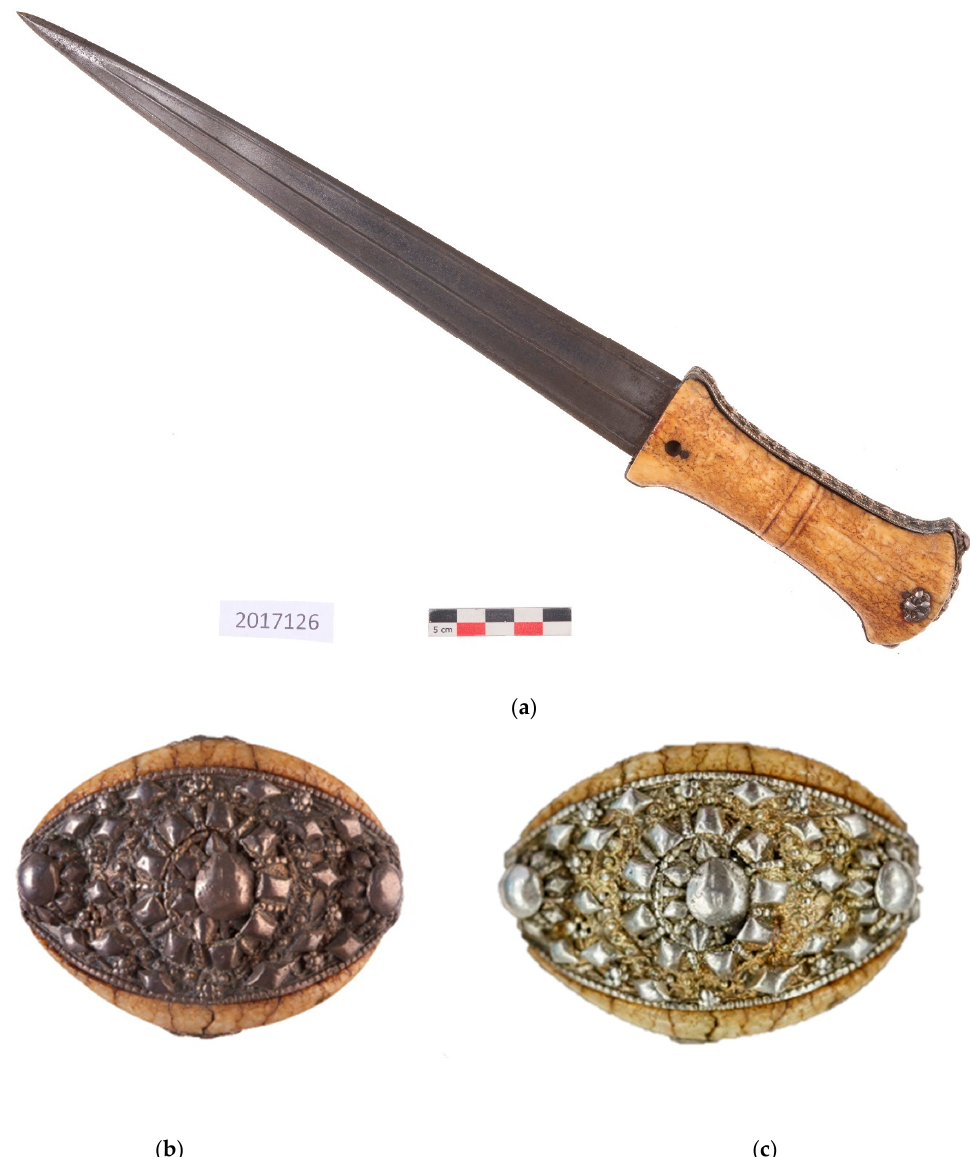
Figure 7. A knife from the collection of the Pierre Loti Museum ( a ), and of a detail of the handle before ( b ) and after treatment ( c ) (© J.G. Aubert/Arc’Antique—Grand Patrimoine de Loire Atlantique, Nantes,